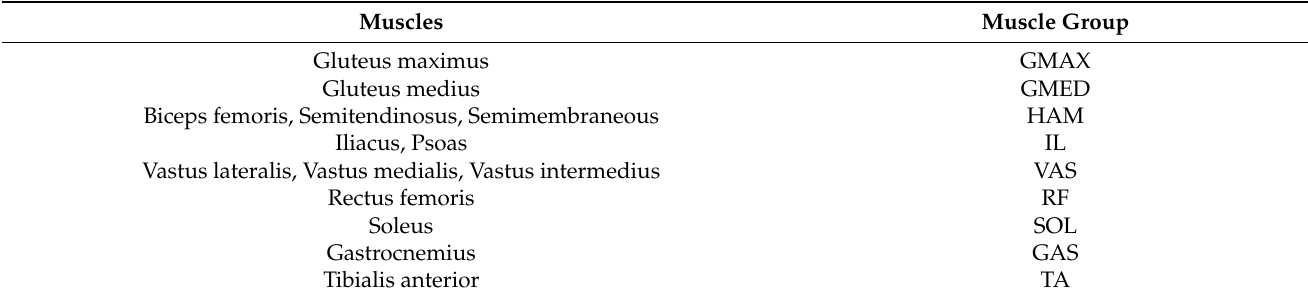
Table 1. Intact leg muscles included in the analysis.